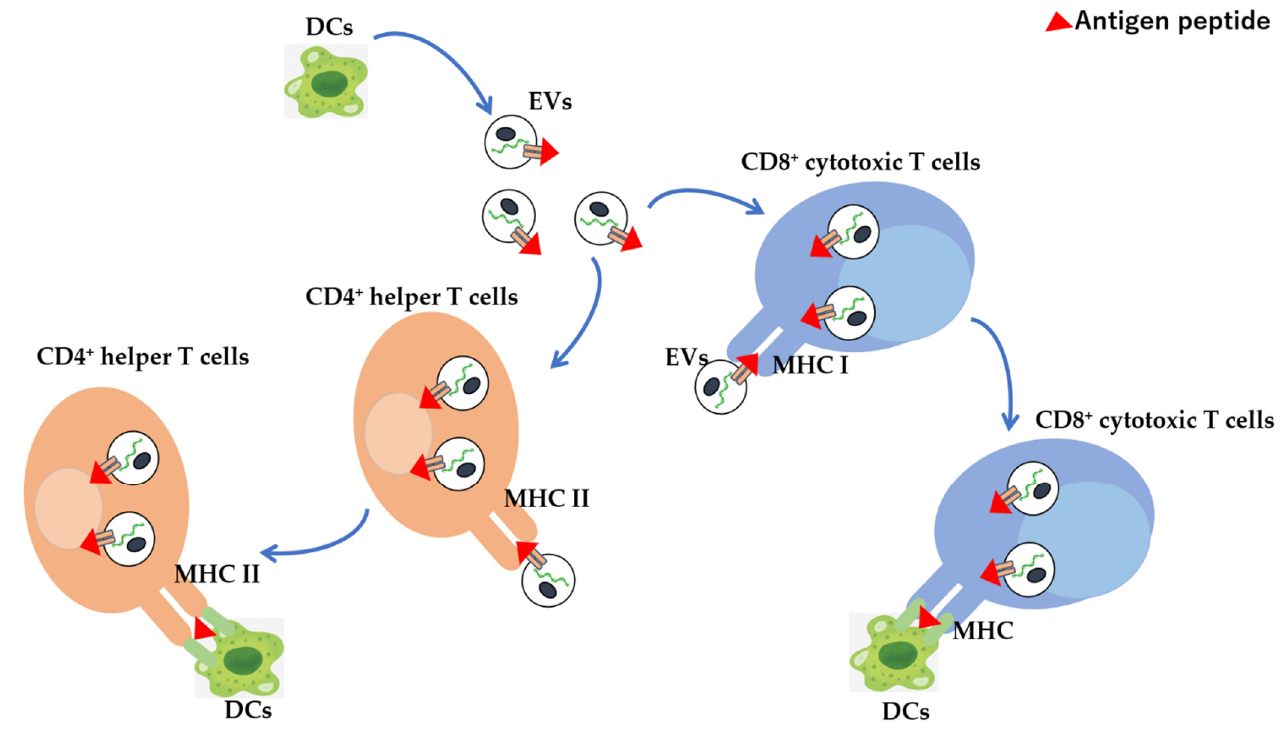
Figure 2. EV-mediated antigen presentation to CD4+ helper or CD8+ cytotoxic T cells from dendritic cells. DC-derived EVs, which can migrate to tumours or the spleen directly or indirectly present antigens to CD4+ helper and CD8+ cytotoxic T cells via MHC molecules, thereby inducing immune responses. Red triangle: antigen peptide.